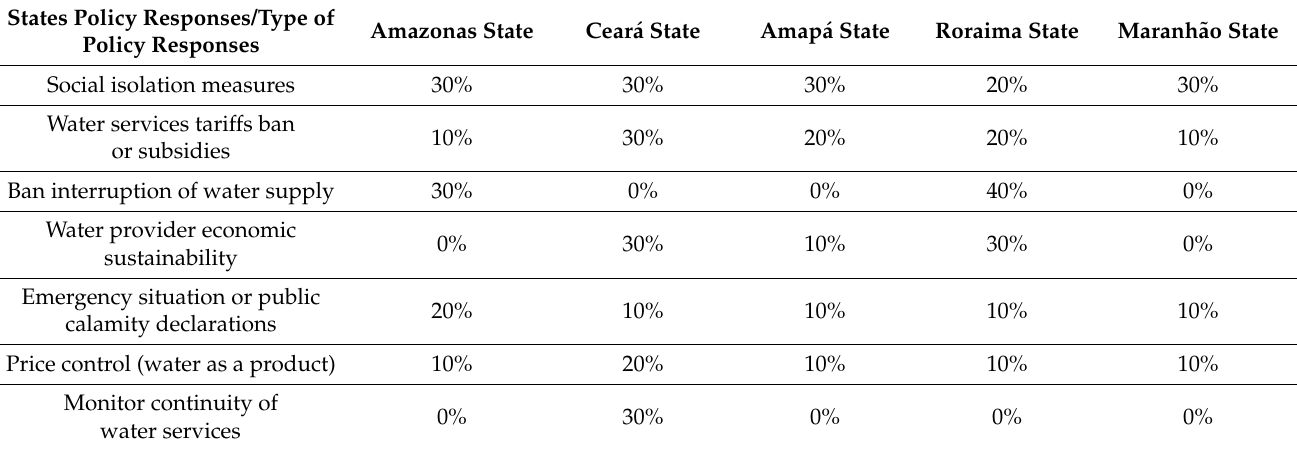
Table 6. Percentage of states response per type of policy